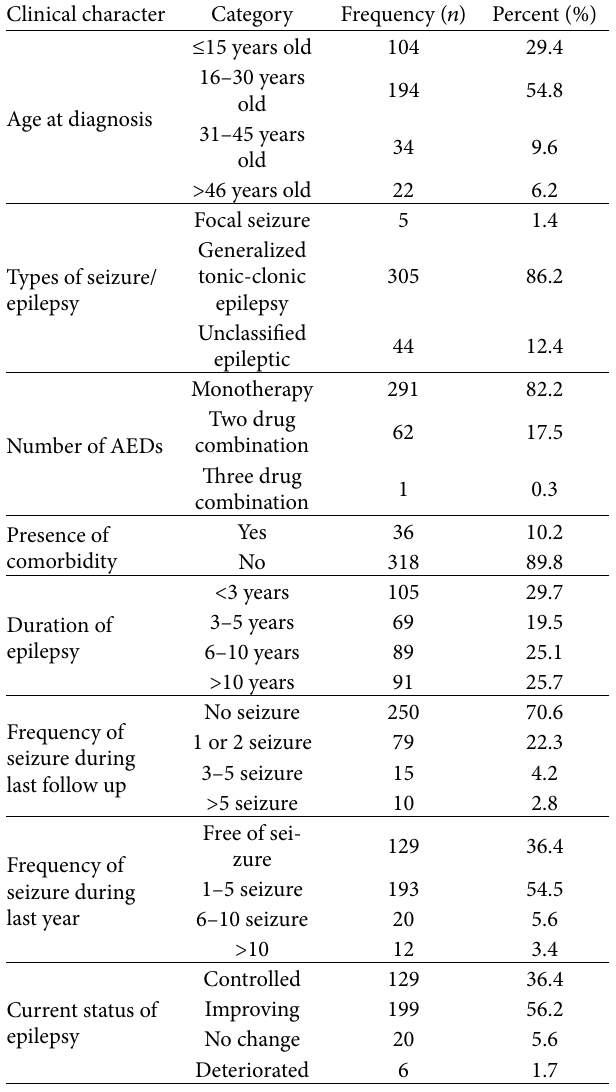
Table 2: Clinical characteristics of study participants at UoGRH; Northwest Ethiopia,